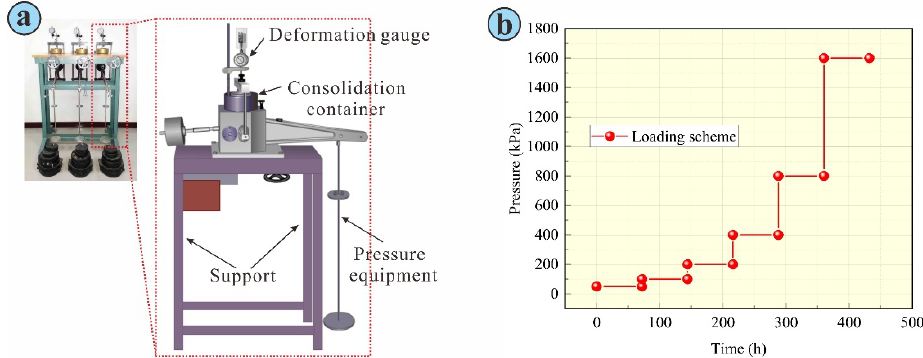
Figure 4. Creep equipment and loading scheme: ( a ) Consolidation instrument; ( b ) Loading-time curve.